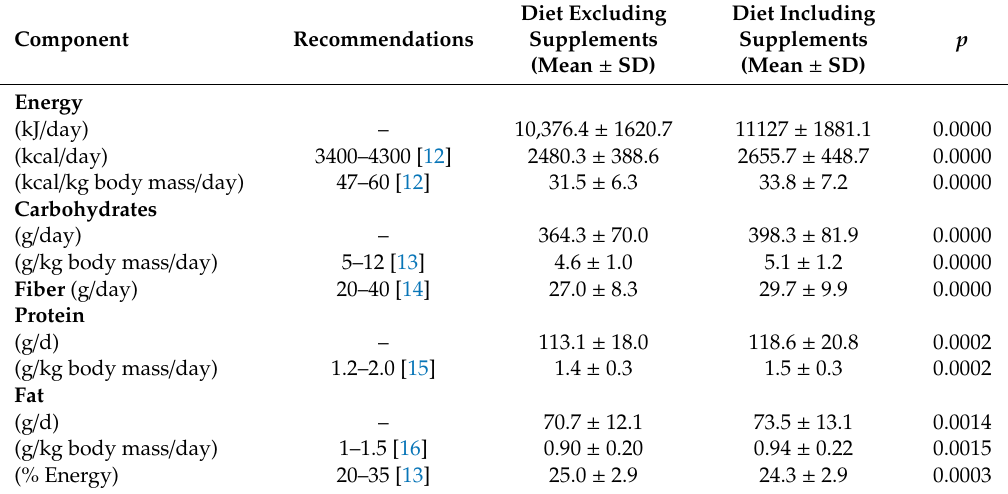
Table 4. Energy and macronutrient intake data collected via a 7-day food